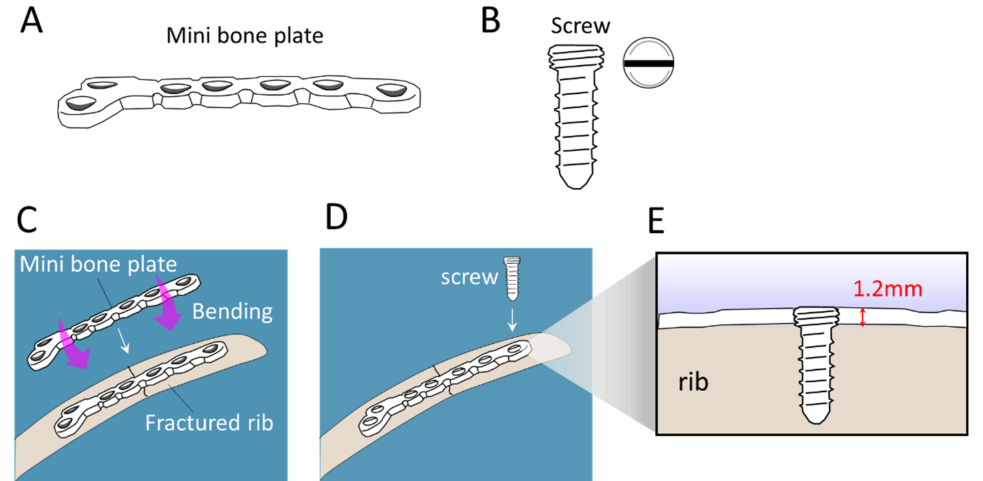
Figure 2. Schematic illustration of the configuration of a Mini bone plate and its implantation in the scenario of repairing a rib fracture. ( A ) General configuration of a Mini plate. ( B ) The Mini screw. ( C , D ) The Mini bone plate requires manual bending prior to implantation to a bone injury. ( D ) Screwing of the Mini plate. ( E ) The cross-sectional view of a screw-locked 1.2 mm thick Mini